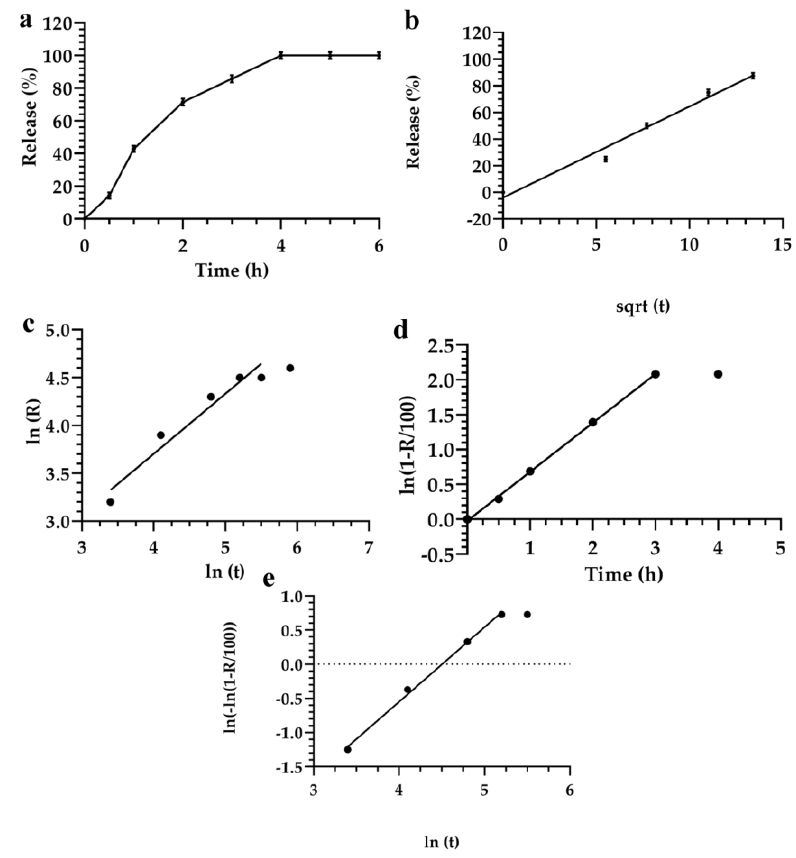
Figure 5. Evaluation of the release profile of fluorescein from lyotropic colloidal liquid crystal formulation 4, using the following mathematical models: ( a ) Linear regression; ( b ) Higuchi; ( c ) Siepman–Peppas; ( d ) Noyes–Whitney; and ( e ) Weibull. Data represents the average of three different measurements ± standard deviation. Error bars, if not shown, are within the symbols.